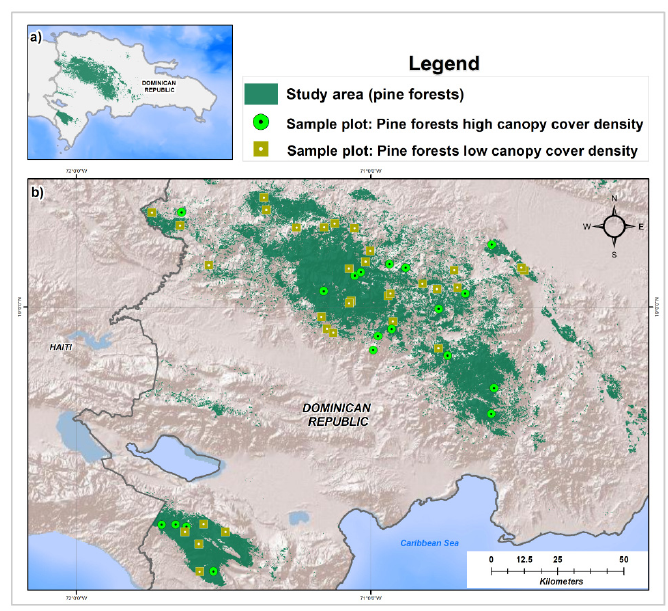
Figure 5. ( a ) General location of the Dominican Republic; ( b ) location of permanent plots in pine forests with low and high canopy cover density.